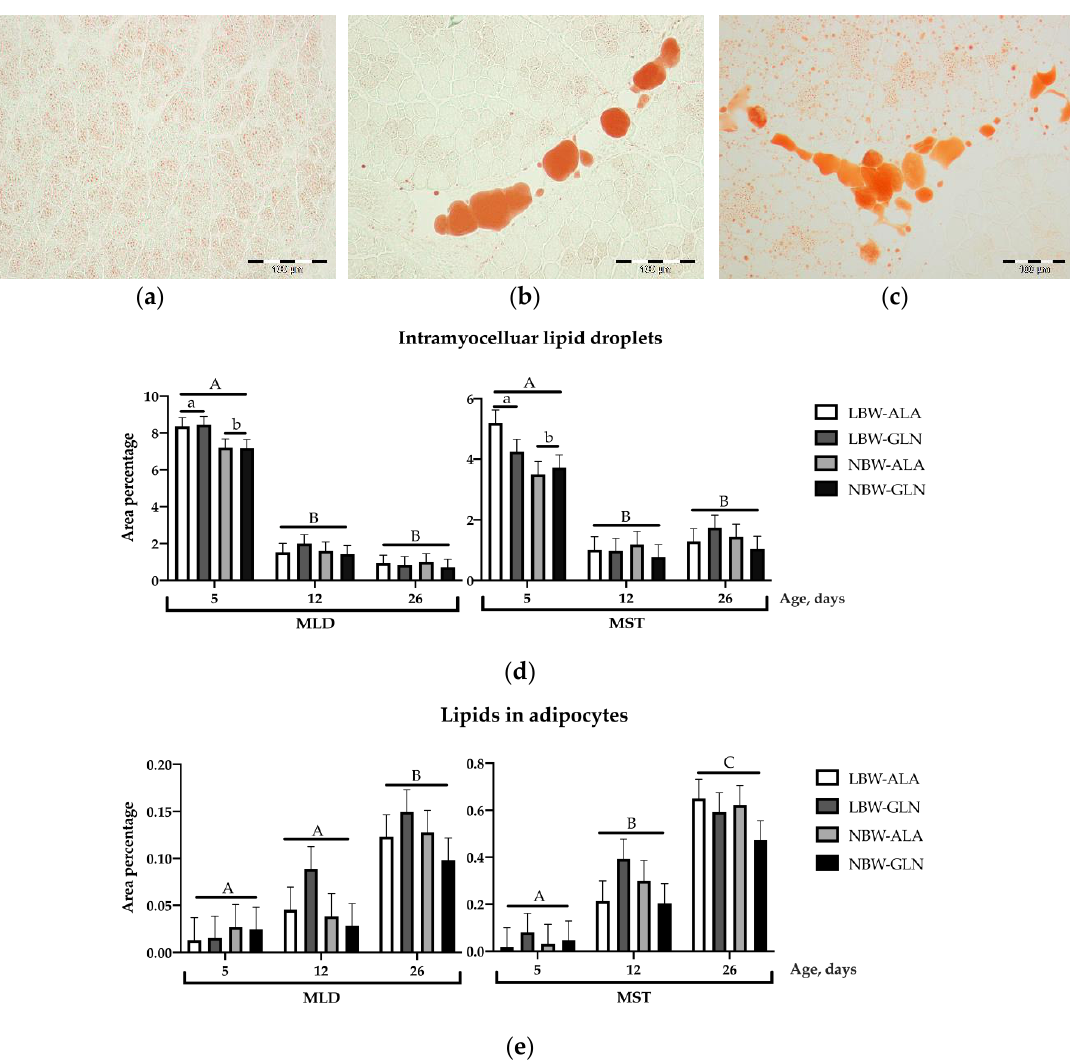
Figure 5. Intramuscular lipid deposition in M. longissimus (MLD) and M. semitendinosus (MST) of low (LBW) and normal birth weight piglets (NBW) supplemented with glutamine (GLN) or alanine (ALA) between 1 and 12 dpn ( n = 12 per group and age). ( a – c ): Oil Red O-stained longissimus muscle sections of piglets at 5, 12 and 26 dpn, lipids are stained red. Scale bar = 100 µm. ( d ): Relative area of intramyocellular lipid droplets. ( e ): Relative area of intramuscular lipids in adipocytes. Values are LSmeans with SE in error bars; a,b indicate significant differences among groups at the same age; A–C indicate significant differences among ages ( p ≤ 0.05, Tukey–Kramer test).